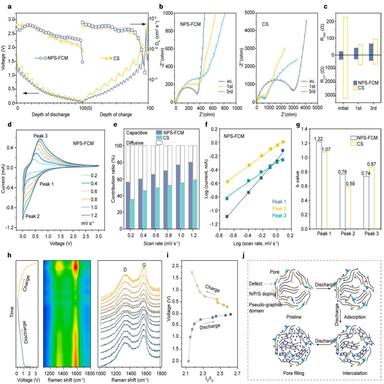
Kinetics and mechanism study. a) GITT curves at 0.03 A g− 1 and calculated K+ diffusion coefficients. EIS plots at different cycles of b) NPS-FCM and CS materials. c) The calculated impedance data of RSEI and Rct. d) CV curves at different scan rates in the range of 0.2–1.2 mV s − 1 and e) the related surface-controlled capacity calculation. f) b-values fitting plots and (g) b results comparison. h) in-situ Raman spectra of NPS-FCM material in the initial cycle at the current density of 0.08 A g− 1 and i) e